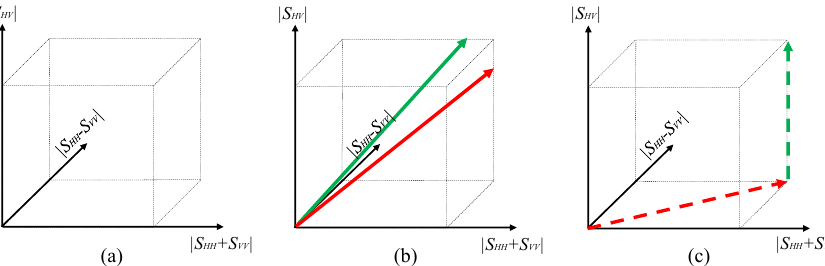
Figure 1. Cartesian coordinates and the representation of scattering models in Cartesian coordinates. ( a ) Cartesian coordinate. ( b ) The representation of similar scattering models (solid line). ( c ) The representation of orthogonal scattering models (dashed line).